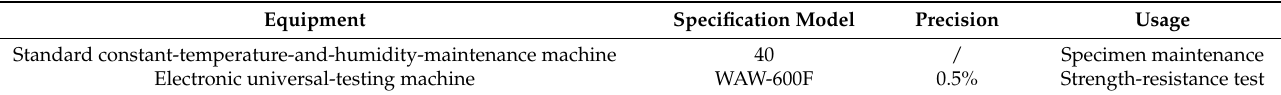
Table 2. Main experimental equipment parameters.